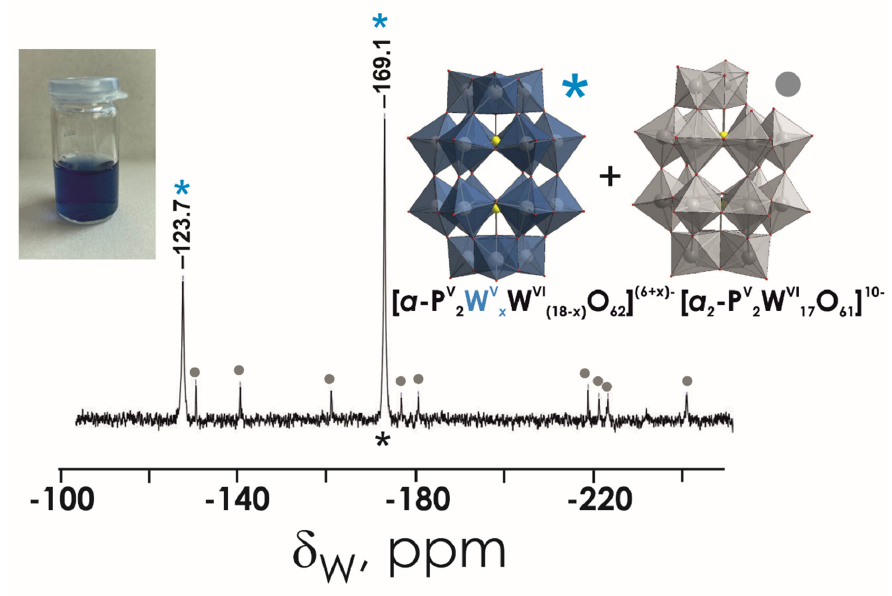
Figure 5. 183 W NMR spectrum of P 2 W 18 20 mM solutions in MHB. The signal at − 123.7 and − 169.1 ppm corresponding to two types of W ions in reduced P 2 W 18 are depicted with a blue asterisk, and 9 signals of monolacunary P 2 W 17 are marked with grey circle. Color code: {WO 6 }, grey or blue; P, yellow; O, NMR Spectroscopy 183 W NMR and 31 P NMR spectra were recorded with a Bruker FT-NMR spectrometer Avance Neo 500 MHz (Bruker, Rheinstetten, Germany) at 25 °C. Chemical shifts were measured relative to 1 M Na 2 WO 4 and 85% H 3 PO 4 . 183 W NMR samples were prepared in 2.7 mL solvent with a POT concentration of 10 mM and measured in 10 mm tubes. The experimental time for 183 W NMR was ca. 60 h, with a standard pulse program at 20.836 MHz and a 63° flip angle with 1 s relaxation delay. Subsequently, 31 P NMR spectra were measured at 202.53 MHz in standard 5 mm tubes. 2.3. Screening of Antibacterial Activity by Agar Diffusion Each bacterial strain was previously grown in GMH at 37 ° C for 24 h. From this culture a loop was transferred to 10 mL of MHB, and the incubation was done at 37 °C overnight. Afterwards, 8 mL of the previous culture (OD 600nm = 0.8–1.0) was transferred into 40 mL of liquefied MH agar medium. The mixture was poured into a sterile Petri dish, which was kept at room temperature, in a laminar flow cabinet, until solidification of the inoculated culture medium. Then, using an inverted sterile Pasteur pipette, 6 mm diameter wells were made into which 40 µL of each compound at the concentrations to be tested were dispensed: for P 5 W 30 , 0.83 mg·mL -1 (100 µM), 1.65 mg·mL -1 (200 µM), 2.48 mg·mL -1 (300 µM), 3.31 mg·mL -1 (400 µM), and 4.13 mg·mL -1 (500 µM). Incubation was conducted at 37 ± 1 °C for 24 h. The assay with the S. pneumoniae D39 bacteria was carried out in Columbia agar (Oxoid, Basingstock, UK) supplemented with 5% sheep blood (Oxoid, Basingstock, UK) and under microaerophilic conditions. Three biological replicates and two technical replicates were performed. After 24 h incubation, the inhibition zone was determined (Table S4). Determination of the Minimum Inhibitory Concentration The minimum inhibitory concentration (MIC) was determined by microdilution using 96-well flat bottom microplates (Sarstedt). Previously, each bacterial strain was grown in GMH at 37 ° C for 24 h. From this culture a loop was transferred to 10 mL of